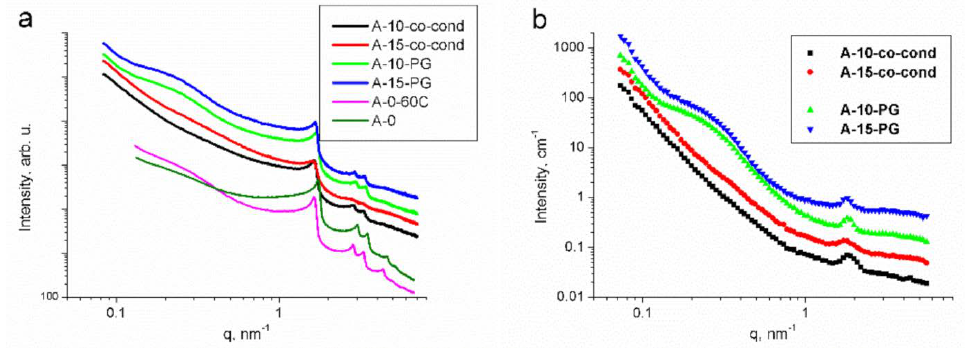
Figure 3. Small angle X-ray scattering (SAXS) ( a ) and Small Angle Neutron Scattering (SANS) ( b ) scattering curves of the parent and the functionalized mesoporous silica samples. The data have been rescaled for better visibility. A-0 refers to the calcined sample prepared only with tetraethoxysilane (TEOS), and A-0-60C is the same material prior to